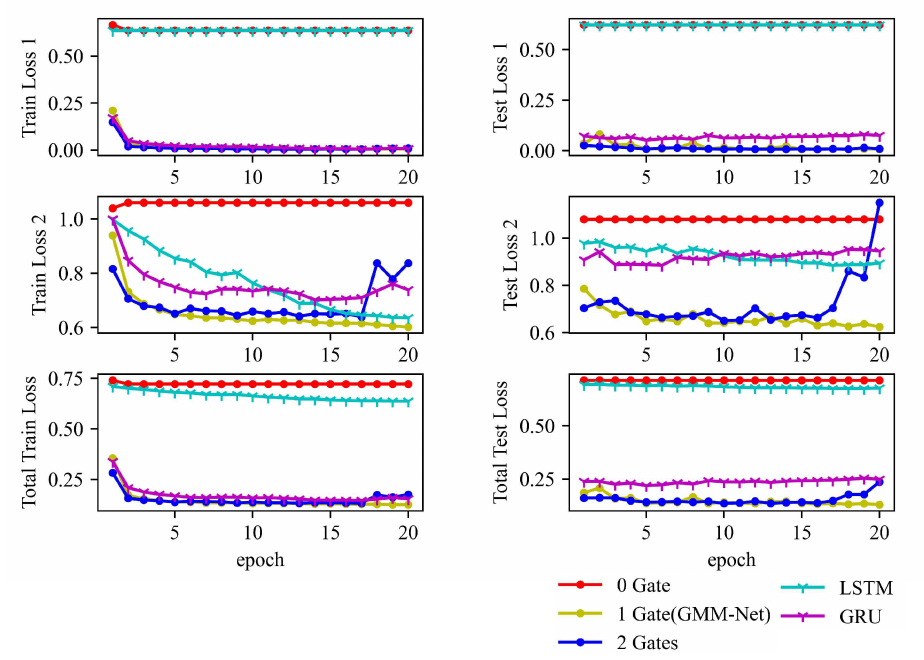
Figure 11. Loss trends of five models.